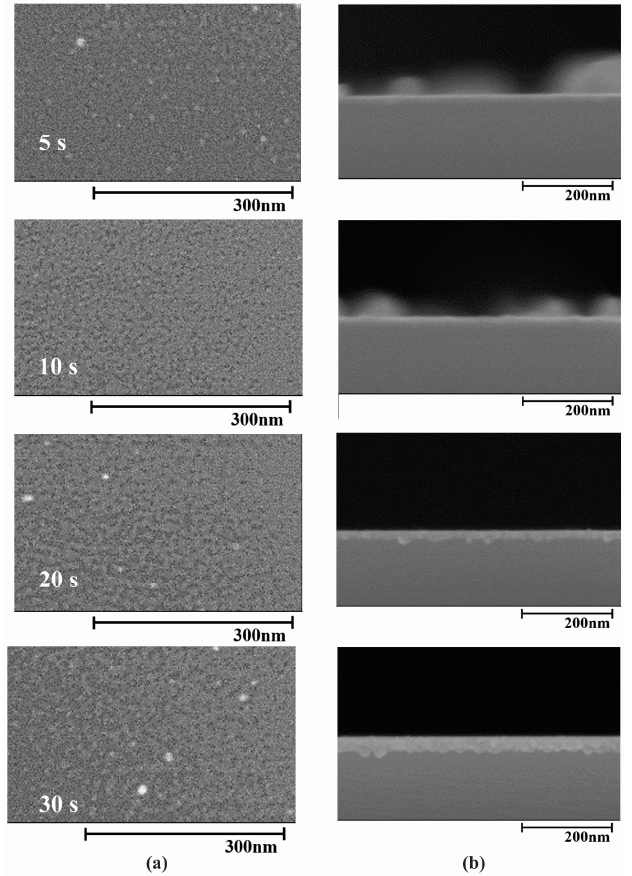
Figure 3. ( a ) Surface and ( b ) cross-sectional FE-SEM images of Ag–Ta thin films deposited on Si substrates at various deposition times . substrates at various deposition